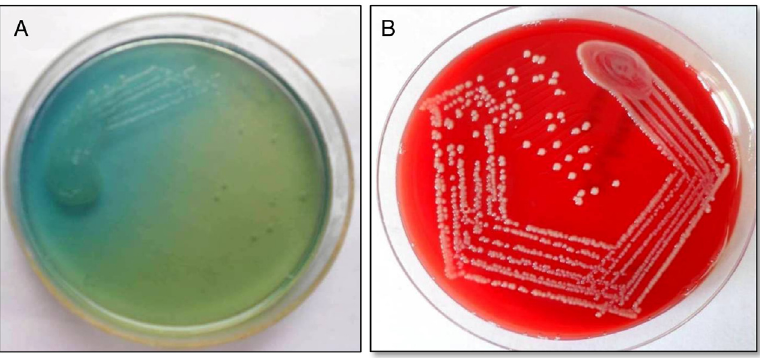
Figure 1 (A) Confluent growth and isolated green colonies of P. aeruginosa on nutrient agar plate; and (B) methicillin resistant colorless colonies of S. aureus (MRSA) on blood agar plate.